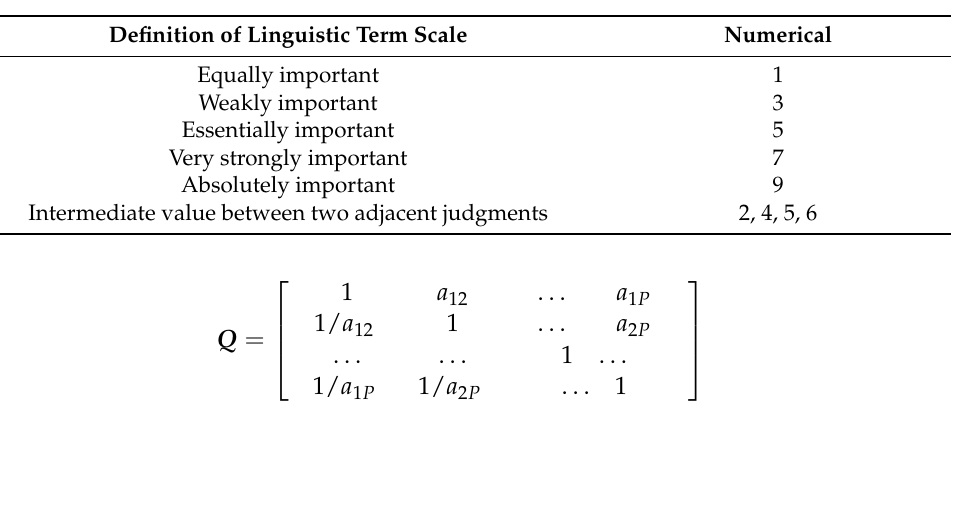
Table 4. Linguistic term